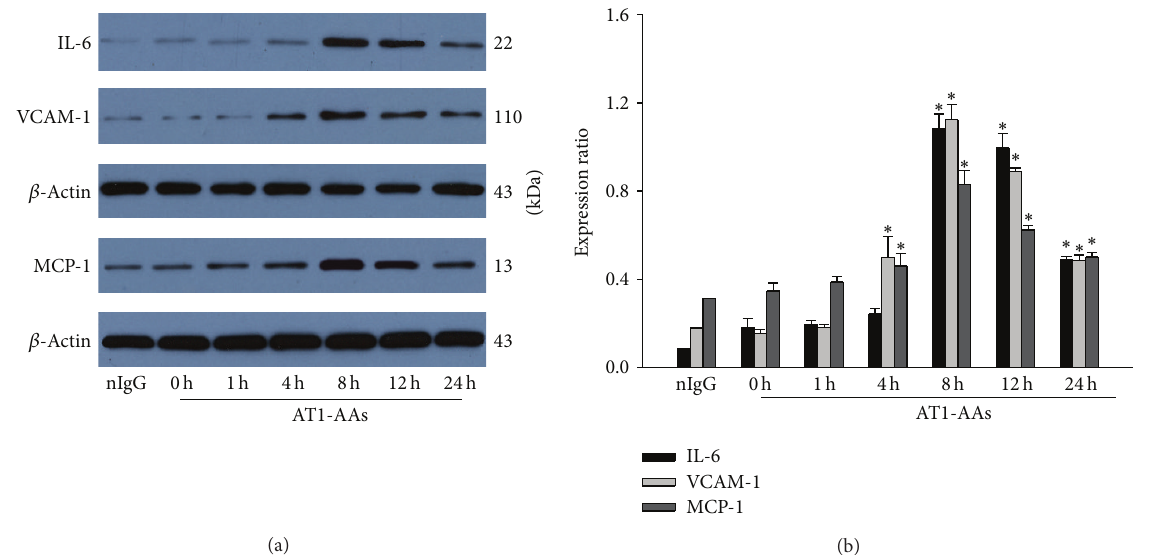
Figure 4: IL-6, VCAM-1, and MCP-1 protein expression in human endothelial cells stimulated by AT1-AAs. After incubation with AT1-AAs for 0, 1, 4, 8, 12, and 24 hours or human nonspecific IgG from the patients for 12 hours as a negative control, the IL-6, VCAM-1 and MCP-1 (panel (a)) protein levels were determined by Western blot analysis. 𝑦 -axis represents the relative protein levels, 𝛽 -actin used as a protein loading control. Panel (b) was the summarized data from 5 independent experiments; ∗ 𝑃 < 0.05 versus 0 hour (control); 𝑁 = 6 . (nonspecific IgG group 𝑛 = 1 ).